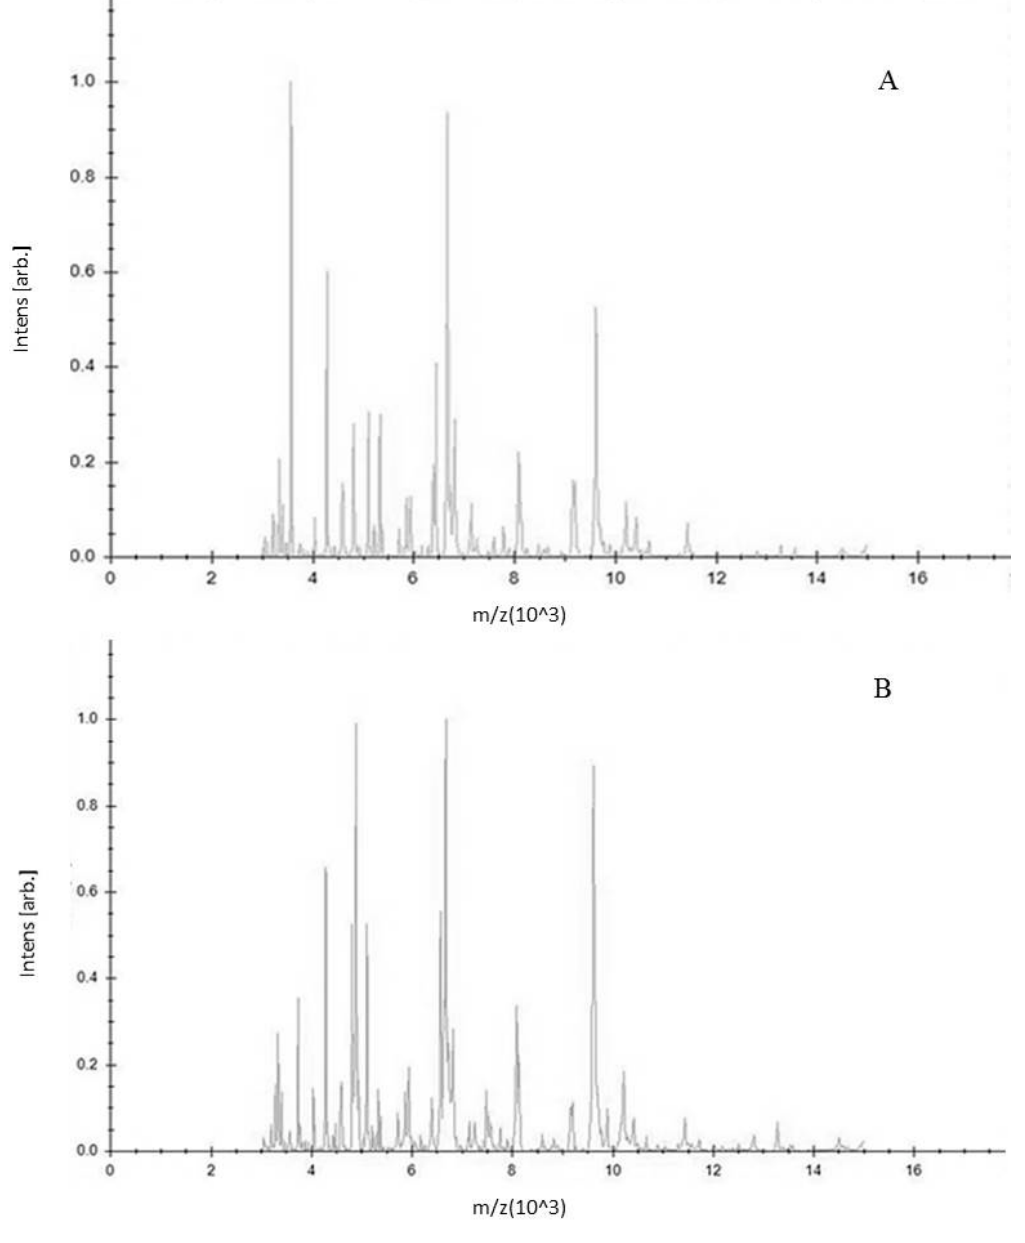
Figure 3. ( A ) Main Spectrum Profile of S. epidermidis ATCC 12,228 (non-biofilm producer); ( B ) main Spectrum Profile of S. epidermidis ATCC 35,984 (biofilm producer). They were obtained as a mean value of sixty mass spectra using MALDI Biotyper 3.0 software. The m / z ratio is shown on the axis of the abscissas, the intensity values is shown on the axis of the ordinates.